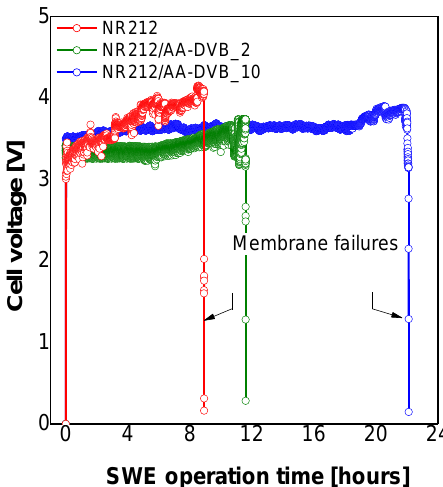
Figure 11. SWE durability test results of NR212 / AA-DVB membranes obtained at the constant current density of 0.6 A·cm −2 . Here, the SWE operation temperature is 90 °C.